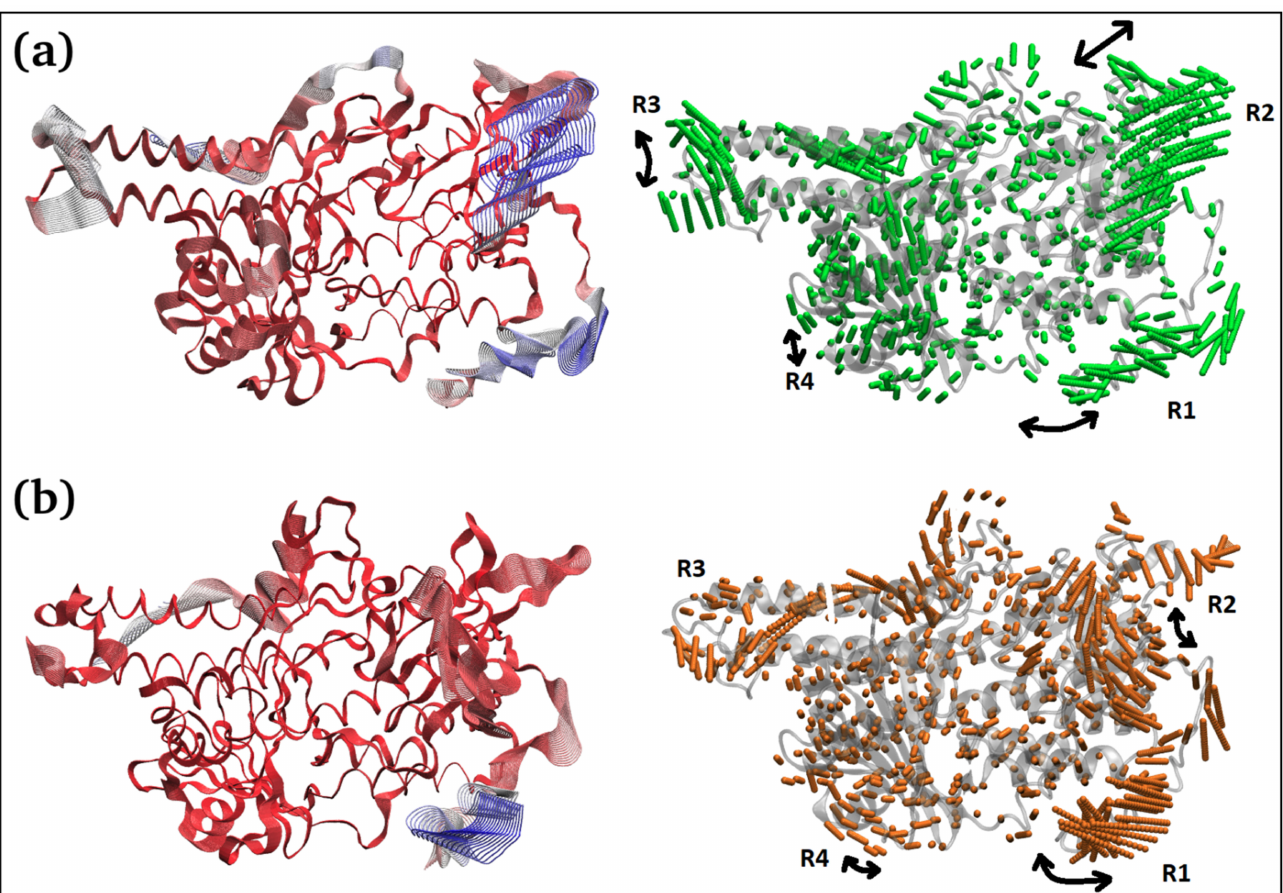
Figure 7. Two different representations of the interpolated structures of the TQ-free ( a ) and bound states ( b ) of the squalene monooxygenase protein complex along PC1 produced by the mktrj.pca() function. On the left, atoms are colored on a scale from blue to red, where blue represents atoms showing large motion amplitudes, and red represents more rigid atoms. Images on the right show the amplitude of motion via a different mode of